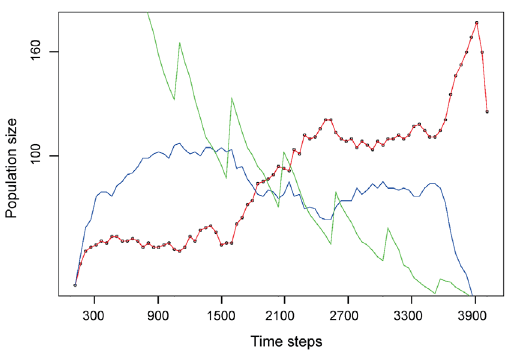
Figure 4. Evolution in population size of ANN and GRN-based robots in a (representative) competition experiment. The X-axis represents the different time steps during the simulation. The red curve shows the population size (Y-axis) of GRN-based robots while the blue curve shows the population size (Y-axis) of the ANN-based robots. The green curve shows the number of available food sources. Increases in the number of food sources are due to the fact that the system will add new food sources with a certain rate after a pre-set number of time steps. See text for details.